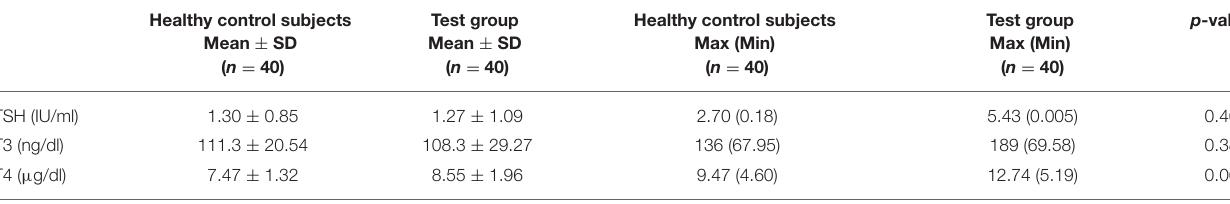
TABLE 2 | Effect of cannabis abuse and/or dependence on thyroid hormones (TSH, T3, and T4).